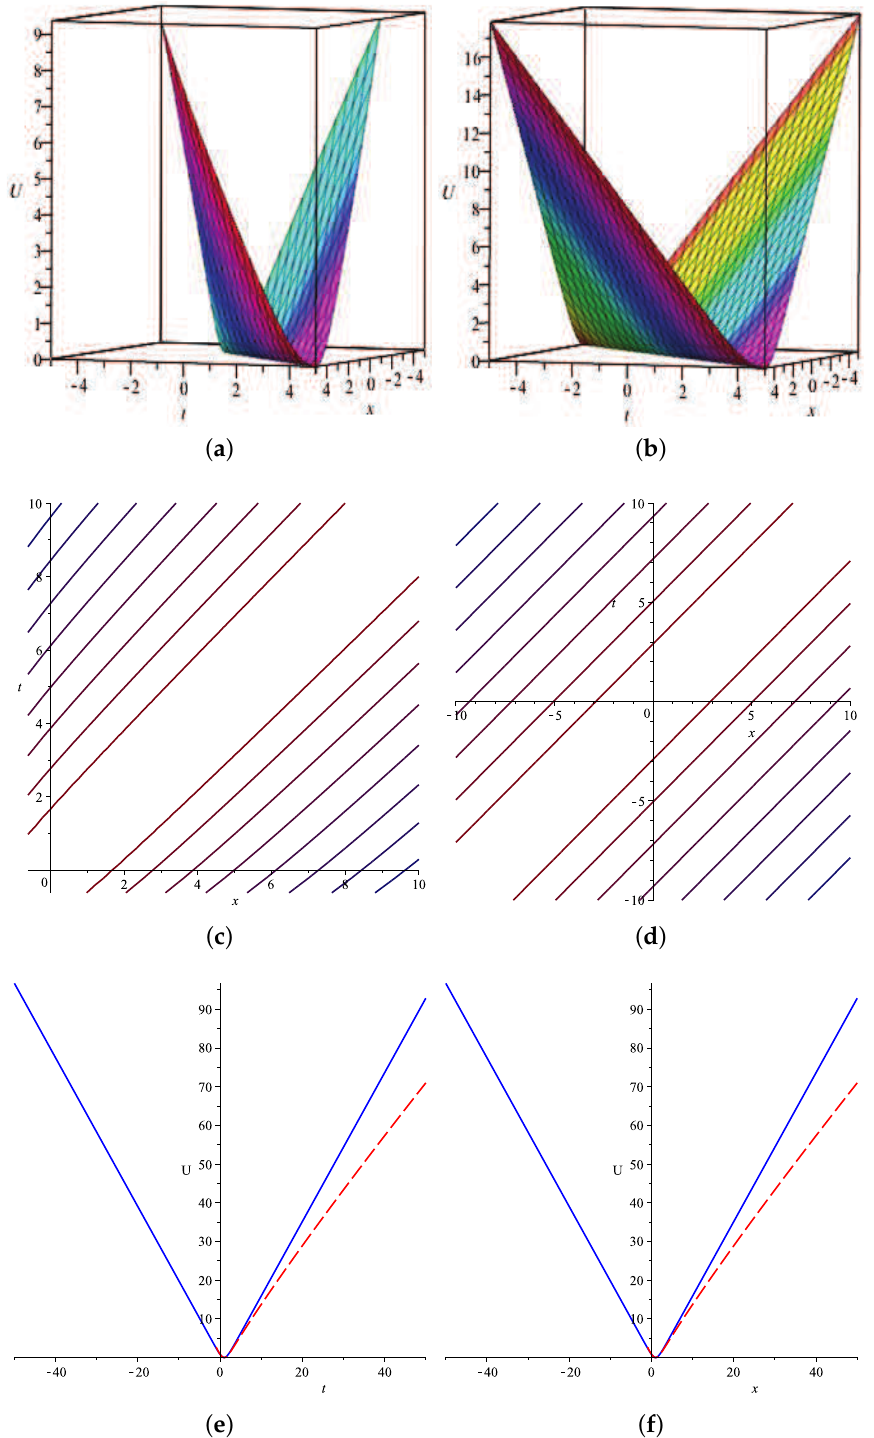
Figure 4. In ( a ), the graph of Equation (36) is given with β = 0.9, whereas, in ( b ), the graph of Equation (37) is given with β = 0.9 and α = 1. In ( c , d ), the 2D contours corresponding to the graphs ( a , b ) are given. ( e , f ) show 2D comparison of both solutions for x = 1 and t = 1,